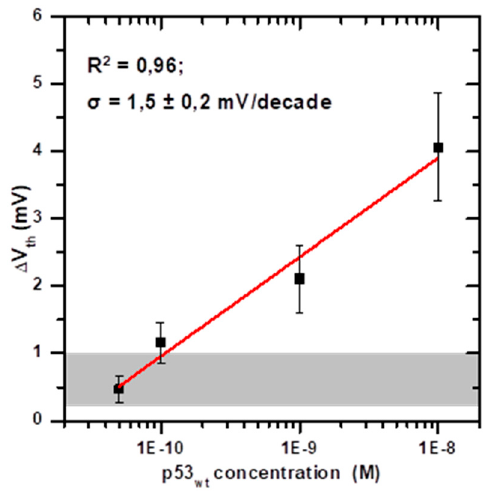
Figure 6. Calibration curve of the BioFET for the detection of p53 wt , as obtained by plotting the average values of the threshold voltage (V th ) variation as a function of the p53 wt concentration in PBS 100 mM pH 8.0, on a semilogarithmic scale. The error bars represent the standard deviation. The regression line (R 2 = 0.96) is reported in red. From the slope of the regression line, the sensitivity σ = 1.5 ± 0.2 mV/decade is obtained. The grey area in the bottom represents the range of V th variations obtained by injecting the working buffer with diluted other proteins (0.6 ± 0.4 mV), which can be considered as the blank signal.